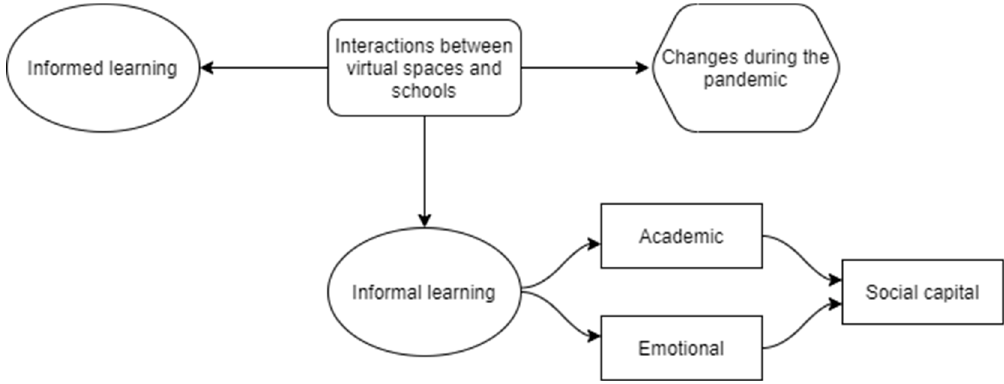
Figure 2. System of categories.